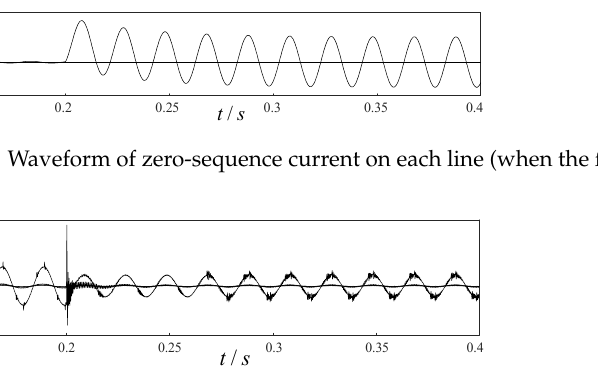
Figure 9. Waveform of zero-sequence current on each line (when the fault occurs on the bus).